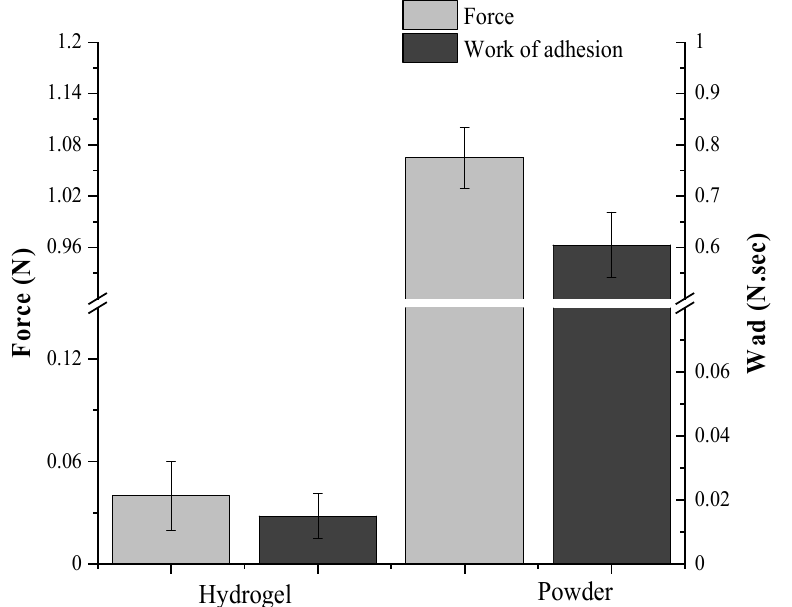
Figure 5. Mucoadhesiveness ex vivo of EPSwk samples.